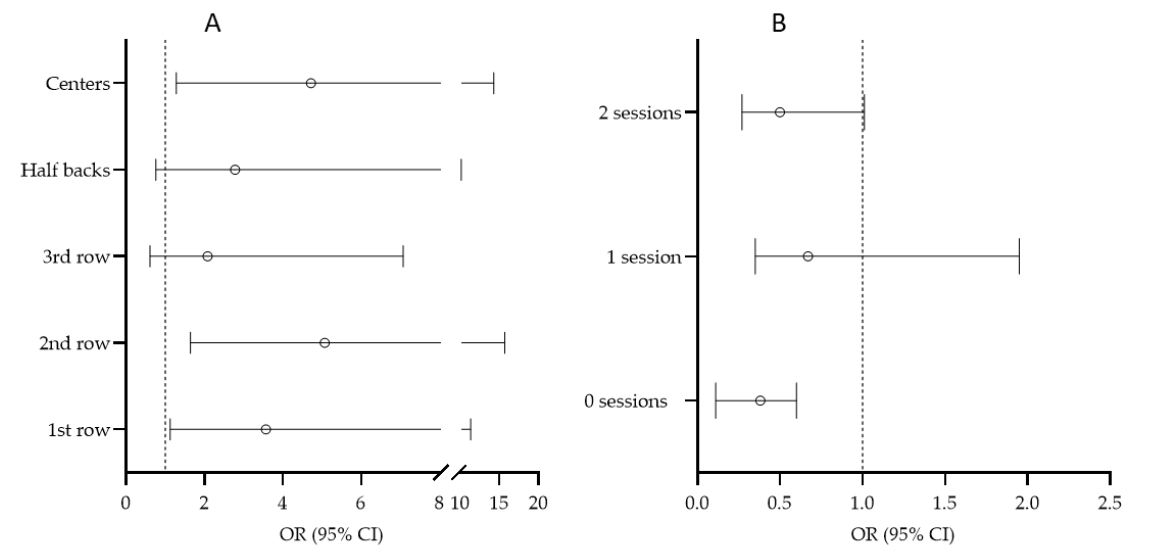
Figure 3. Univariate associations between ( A ) playing positions (with players playing in the last line (Outside backs) as reference value) and ( B ) number of training sessions in a week before the match (with three sessions or more per week as reference value) with injury occurrence .